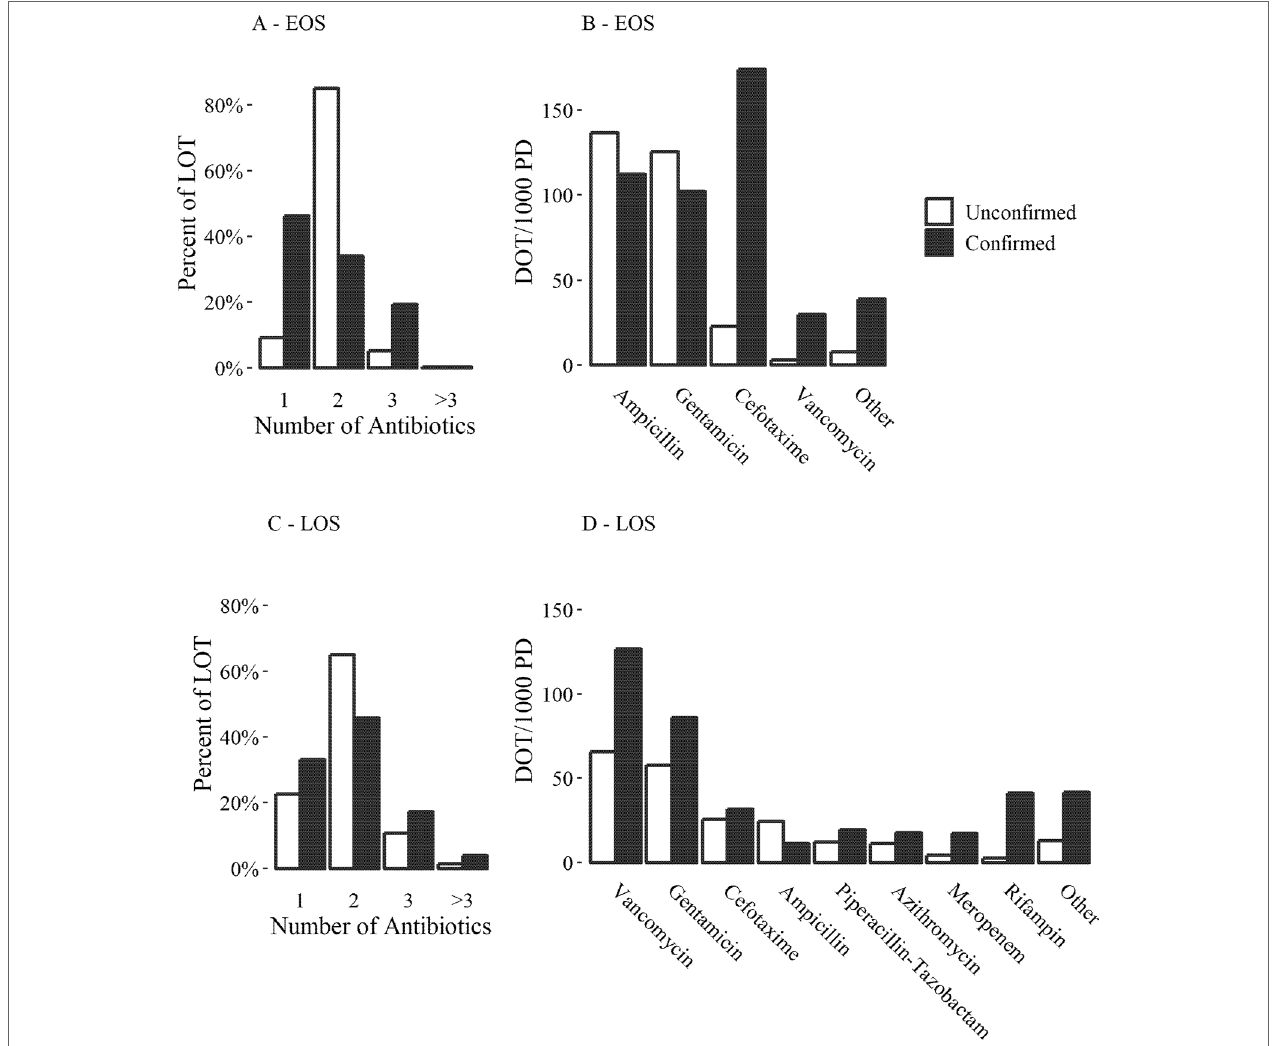
FIGURE 2 | Antibiotic use for treatment of neonatal sepsis. (A and C) number of antibiotics administered per calendar day as a percentage of LOT per cohort. (B and D) —amount of each antibiotic administered as DOT/1,000 PD per cohort. (A and B) figures for early onset sepsis (EOS): only courses started within 3 days of birth are included. (C and D) figures for late onset sepsis (LOS): only courses started within >3–28 of birth were included.